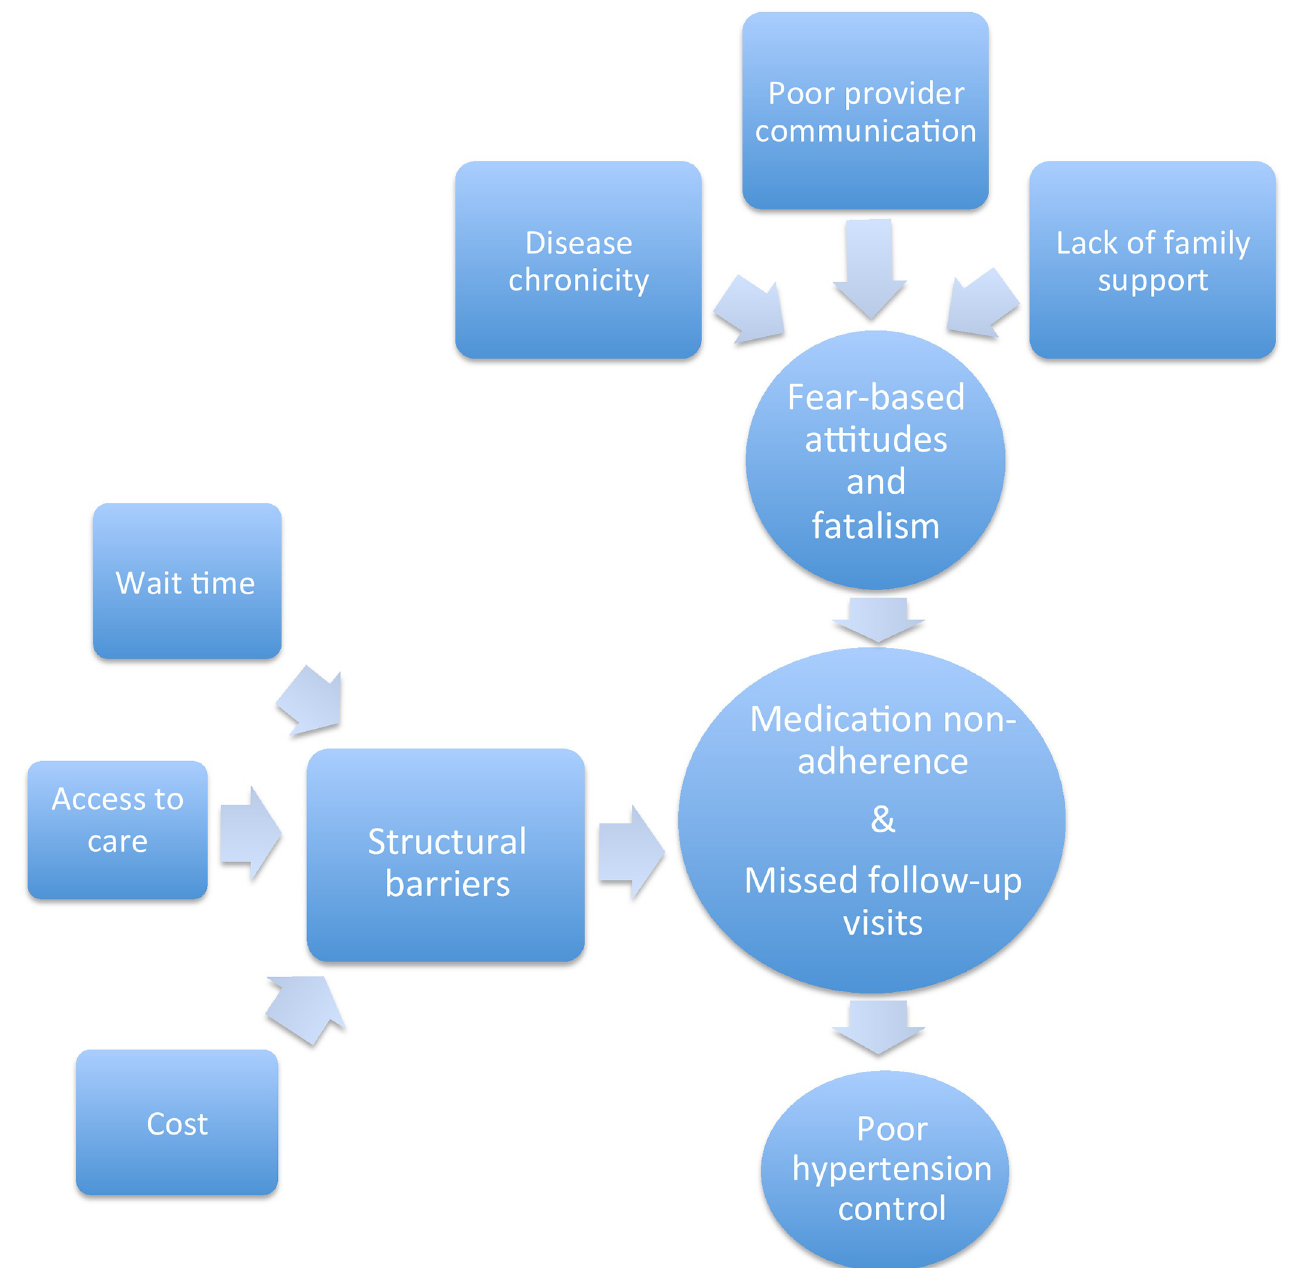
Fig 1. Model of barriers to hypertension